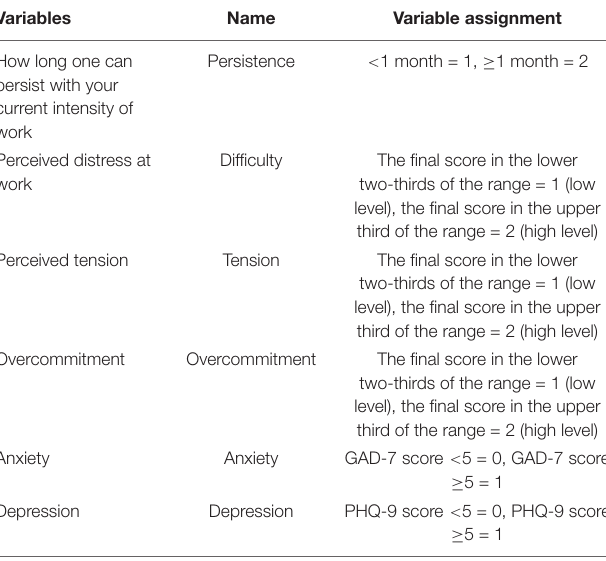
TABLE 6 | Variable descriptions and